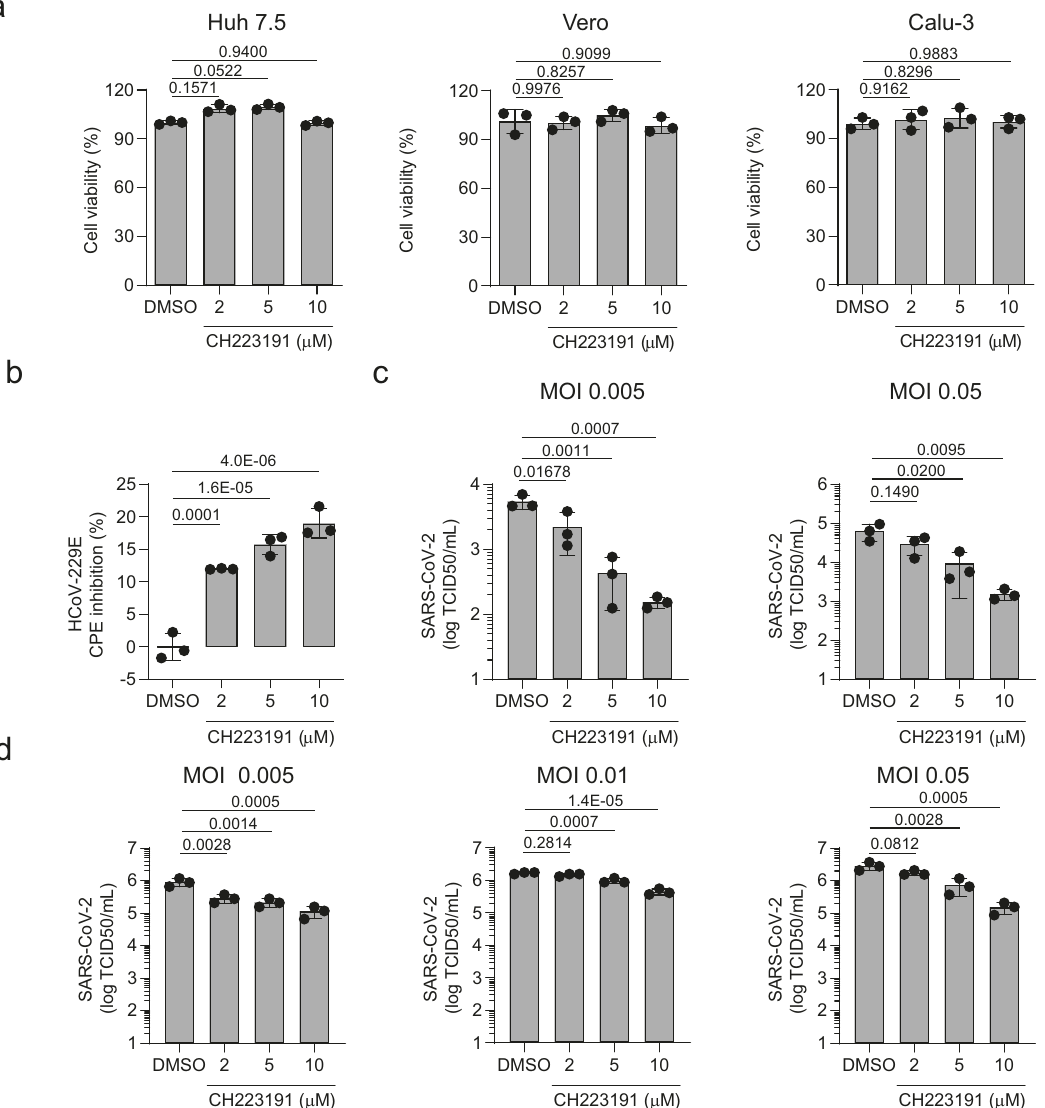
Fig. 5 Pharmacological inhibition of AHR limits CoVs replication in vitro. a Huh 7.5, Vero, and Calu-3 cells were pretreated with the indicated concentrations of the AHR antagonist CH22319 and cell viability was determined using an MTS assay. Data represent the mean ± SD ( n = 3